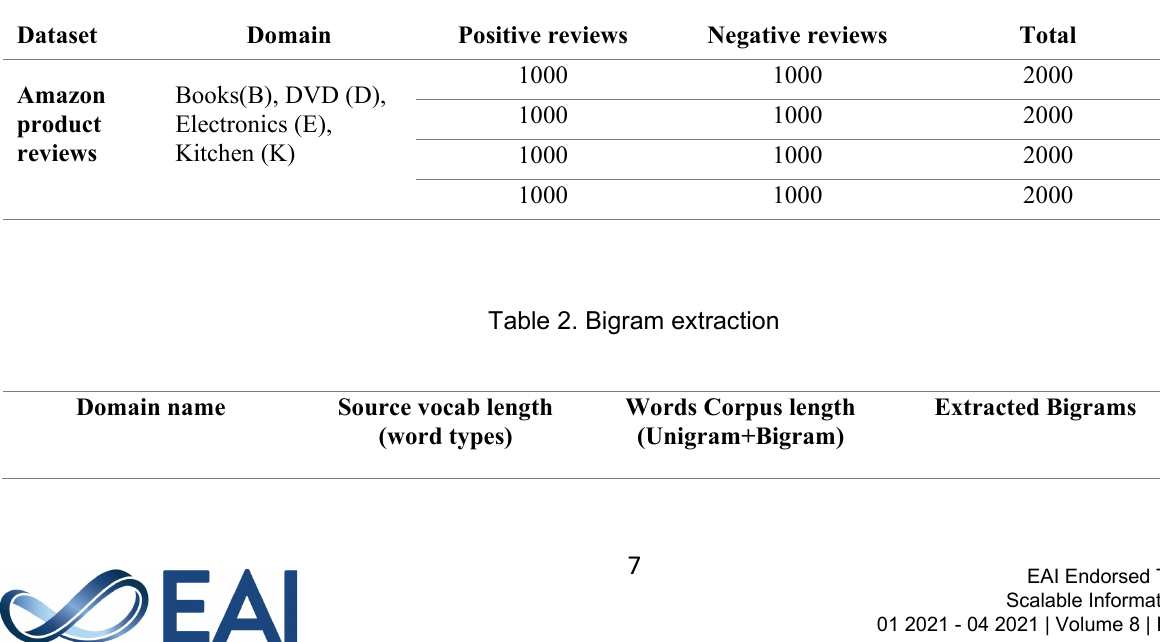
Table 1. Dataset Interpretation